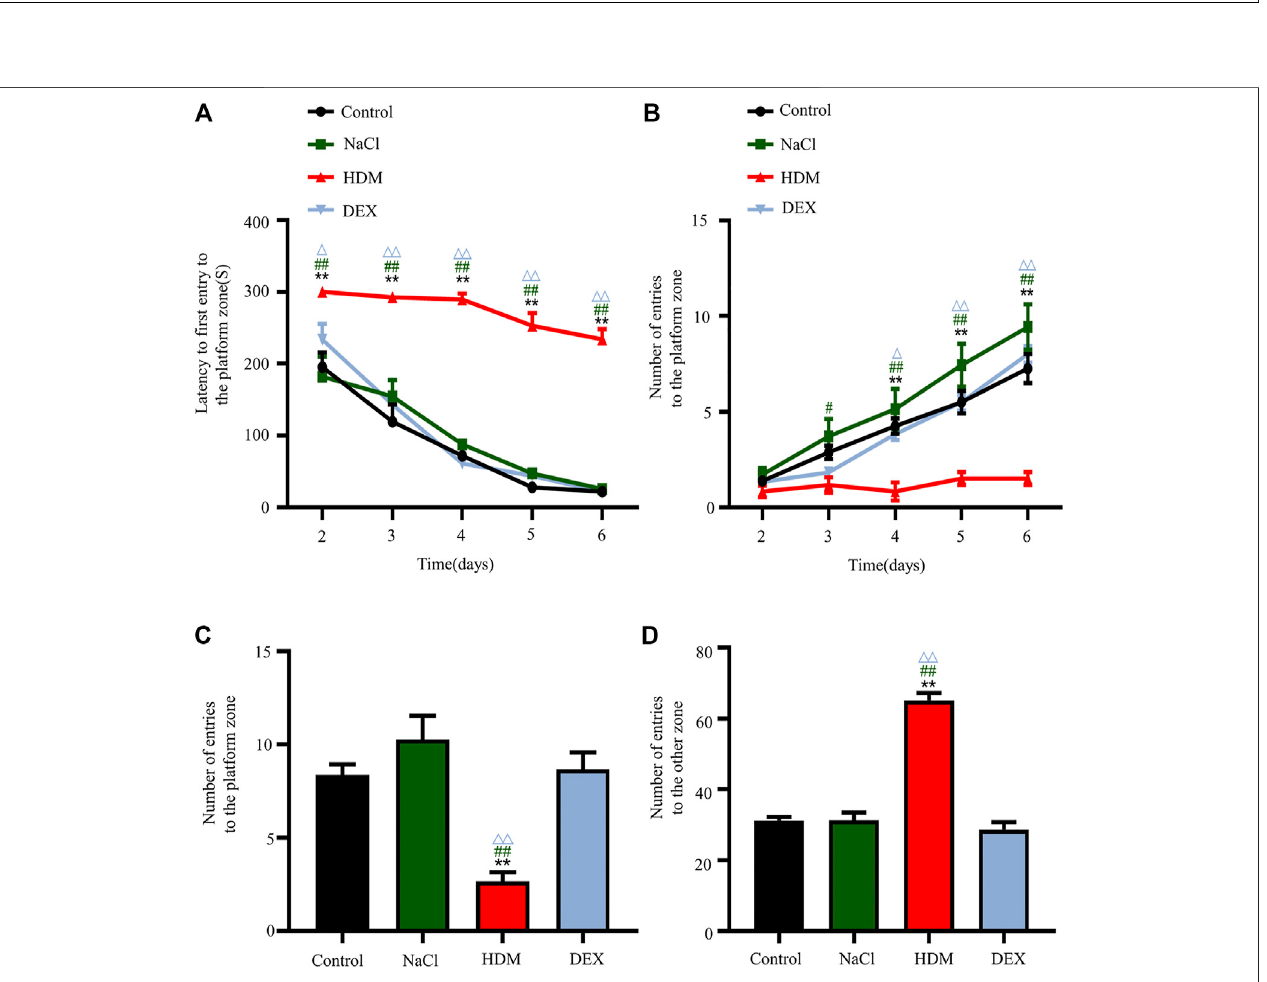
FIGURE4| ThecognitiveabilityoflearningchangedaftermodelingintheHDMgroup. (A) Latencyto fi rstentrytotheplatformzoneintheBarnesmazeexperiment. (B) Number of entries to the platform zone in the Barnes maze training day. (C) Number of entries to the platform zone in the Barnes maze experiment. (D) Number of entries to the other zone in the Barnes maze experiment. n (cid:1) 8. ** p < 0.01 between HDM group and Control group. # p < 0.05 and ## p < 0.01 between HDM group and NaCl group. △ p < 0.05and △△ p < 0.01 between HDM group and DEX group.